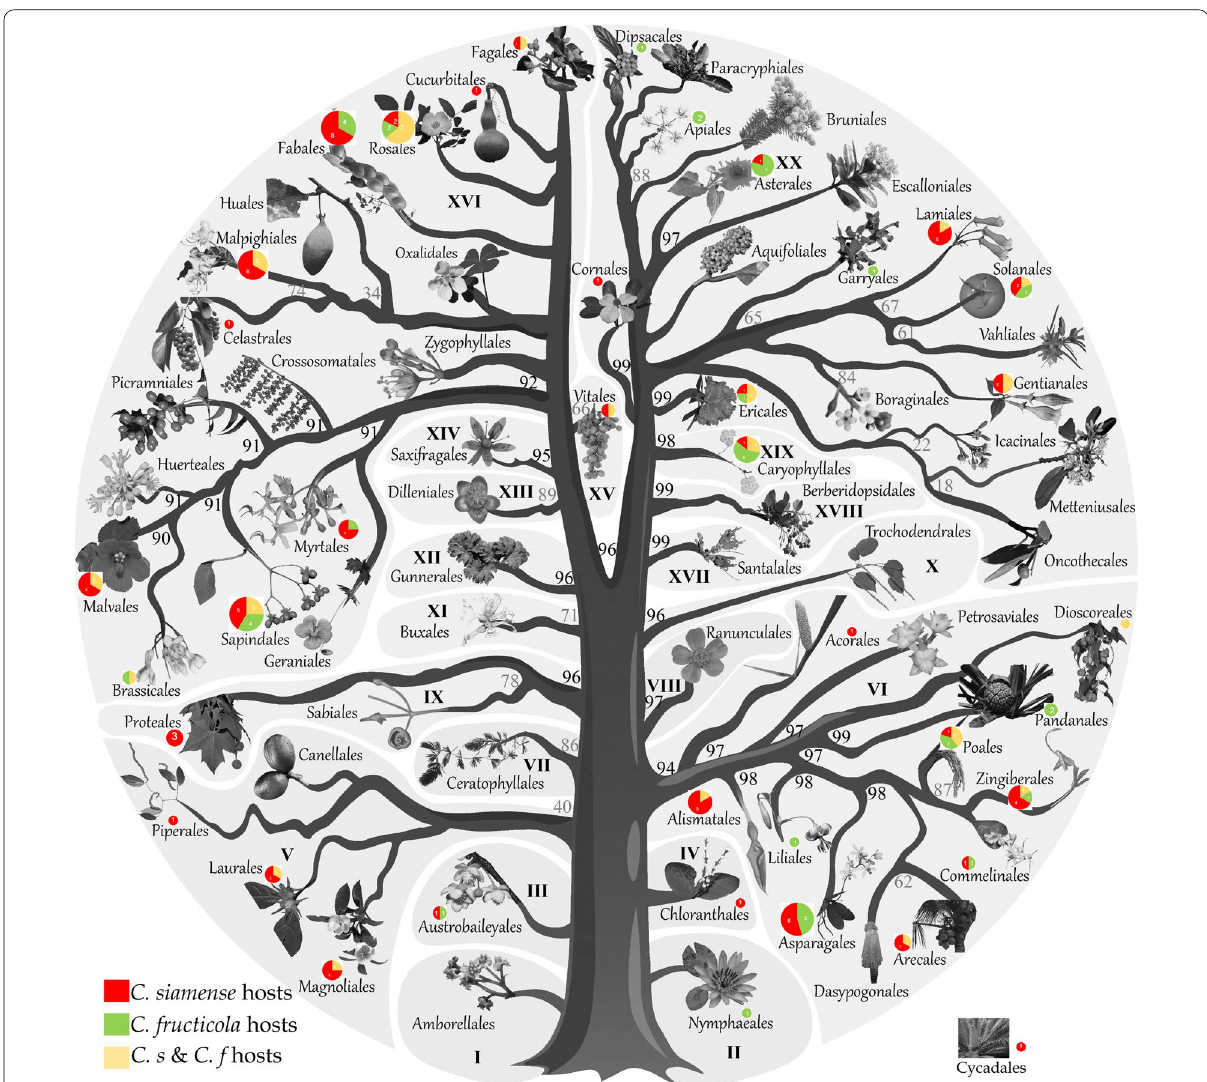
Fig. 4 The taxonomic positions of plants hosting Colletotrichum fructicola and/or C. siamense . Pie charts were generated with the number of host genera belonging to certain order (retrieved at https:// nt. ars‑ grin. gov/ funga ldata bases/ and distinguished at https:// www. iplant. cn/ during July 2022) listed in Additional file 1: Table S1. Red for hosts of C. siamense , green for those of C. fructicola , and yellow for the common hosts shared by two Colletotrichum species. A total of 38 orders were marked in the phylogenetic tree of angiosperms (68 orders) modified from Figure S1 of Li et al. (2021). The unique gymnosperm host of C. siamense was shown at the bottom